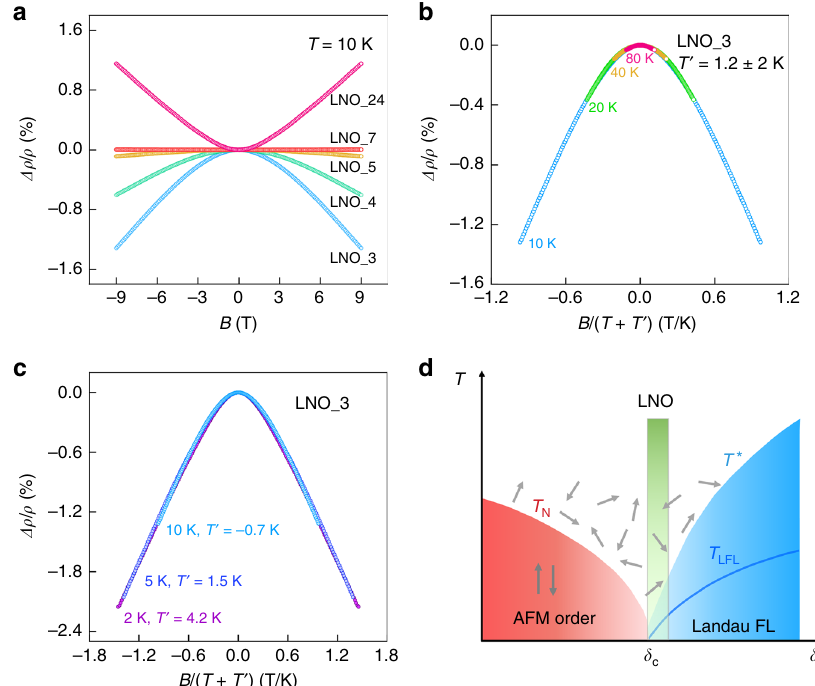
Fig. 4 Magnetotransport measurements and phase diagram. a Longitudinal magnetoresistance measurements for a series of samples at 10 K. b , c The negative LMR measured on LNO_3 at temperatures above and below 10 K, respectively. The x -axis is scaled by B = ð T þ T 0 Þ as discussed in the text. d Phase diagram of a system with Kondo lattice character. Green rectangle represents the position where LNO is likely to sit. T * marks the temperature at which Kondo coherence starts to develop. T LFL represents the temperature below which LFL behavior appears, such as a quadratic temperature dependence of the resistivity. Small arrows with random orientations represent local magnetic